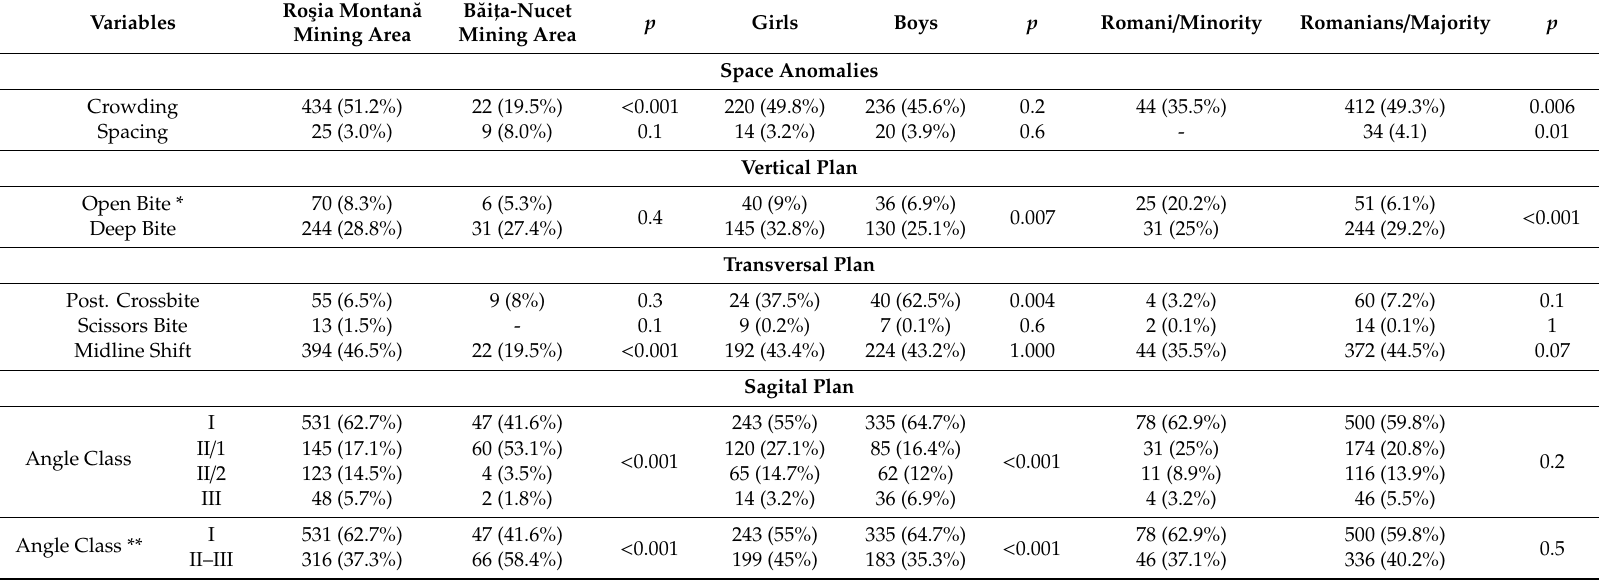
Table 3. Distribution of malocclusions by geographical region, gender and